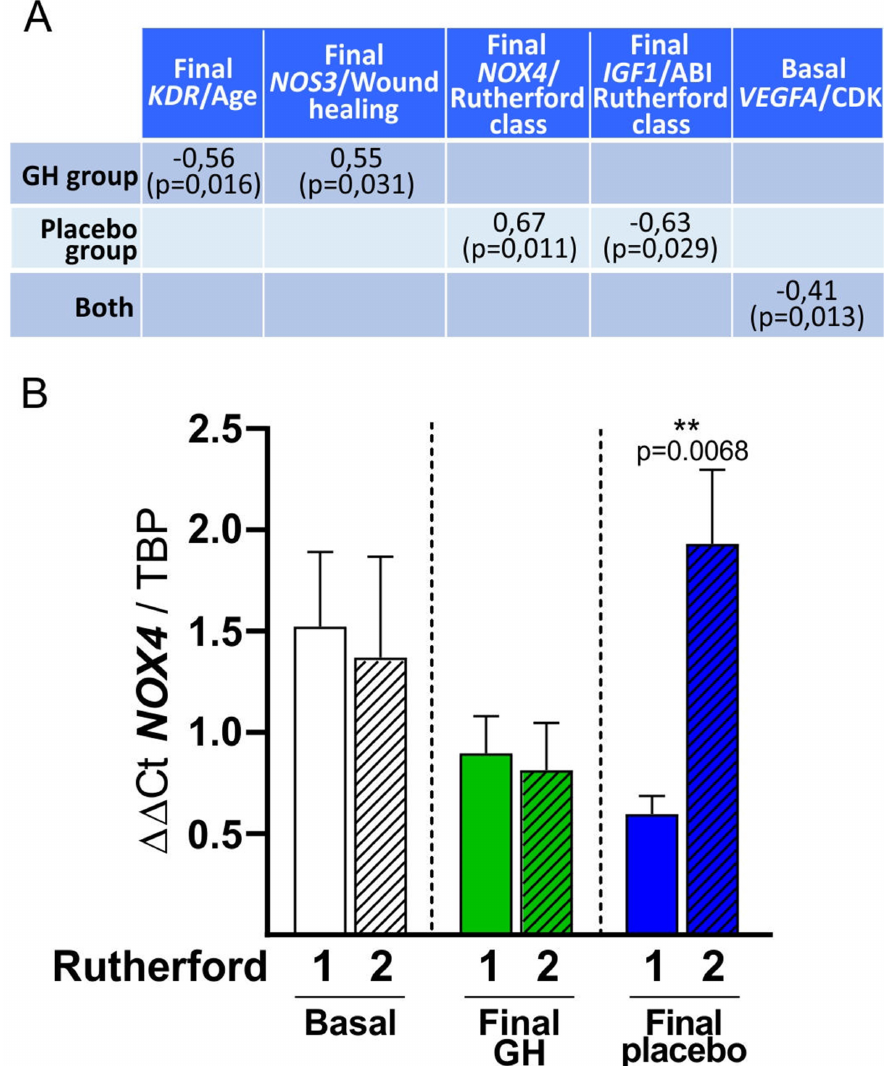
Figure 10. ( A ): Relation between different muscle genes and clinical variables in both groups. ( B ): Graph showing the link between NOX4 mRNA expression and Rutherford class, grouped in 1: less severity of ischemia, and 2: more severity of ischemia. White box: basal level of NOX4 ; Green bars: final level of NOX4 in the GH group; and Blue bars: final level of NOX4 in the placebo group. Striped bars: group with severe ischemia. ** p <